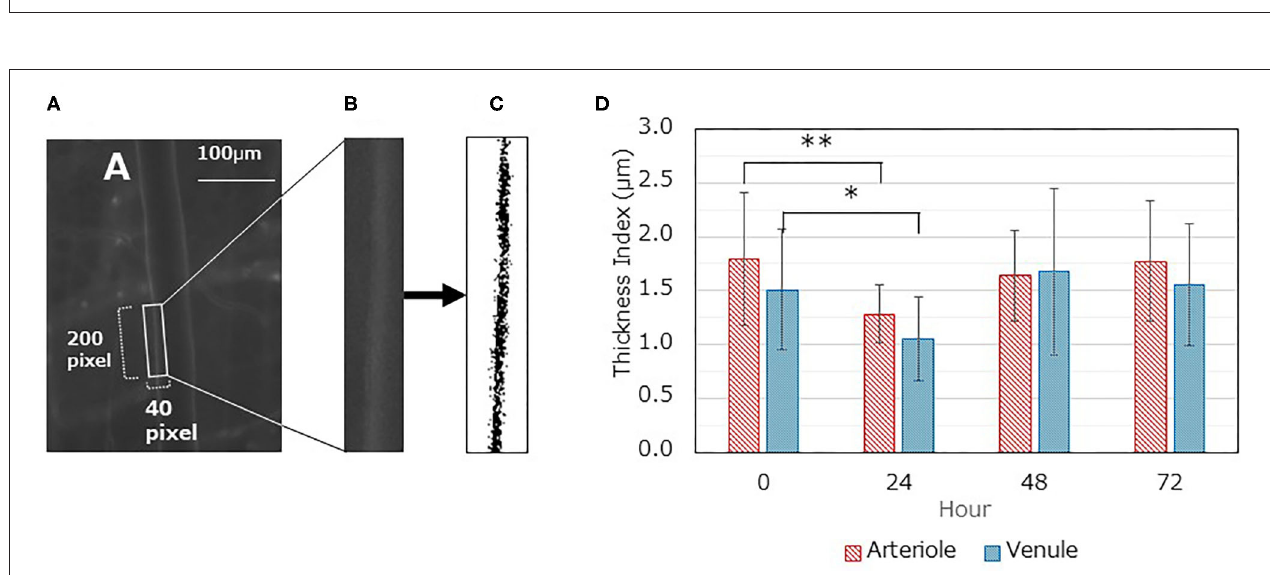
FIGURE 4 | Changes in glycocalyx thickness index (TI) over time. (A-C) A typical image analysis procedure. (A) Gray image displaying fluorescent FITC-WGA lectin; the region of interest (ROI) (40 × 200 pixels) is set as containing one side of the vascular endothelium. The long axis is set similar to the blood flow direction. (B) The ROI image was saved as a separate file. (C) The saved ROI image is binarized according to the threshold value and inversed. The TI value was then calculated. (D) Time dependent changes in TI for both arterioles and venules after LPS administration. Each data item represents the mean ± SD for 21 measurements from three mice for each condition. A one-way ANOVA was performed, and Dunnett’s test was conducted for post-hoc comparisons (* P < 0.05, ** P < 0.01).